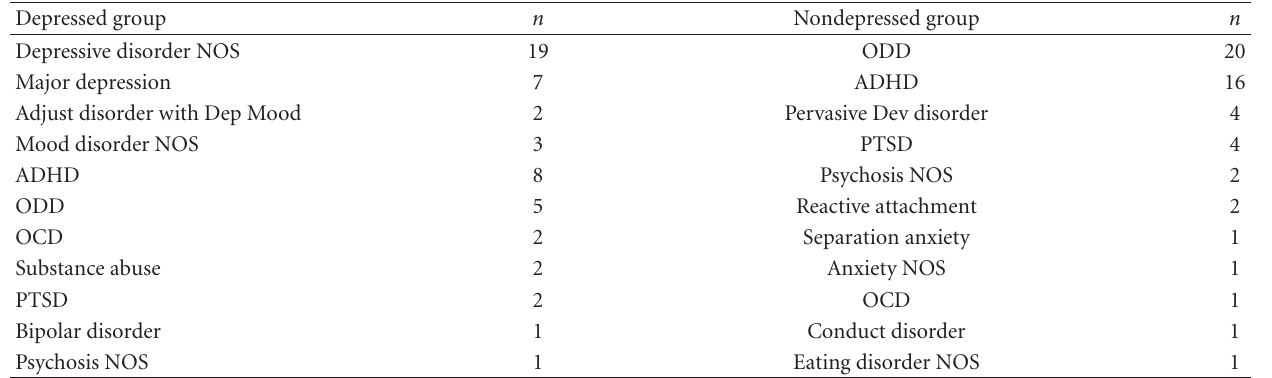
Table 1: Type and frequencies of diagnoses represented in each static